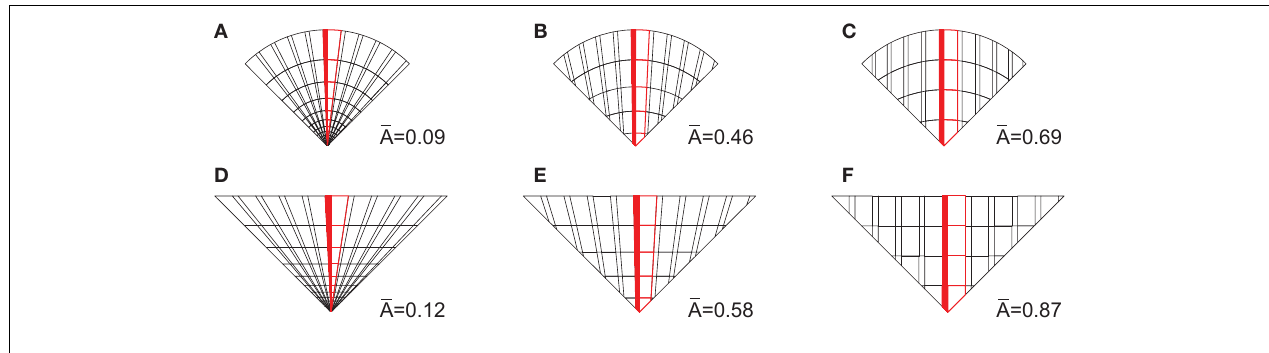
FIGURE 9 |Average segment size along the middle (in red) radius in one quadrant of the (A) circle-radial figures, (B) circle-elliptic figures, (C) circle-paraboloidal figures, (D) square-radial figures, (E) square-elliptic